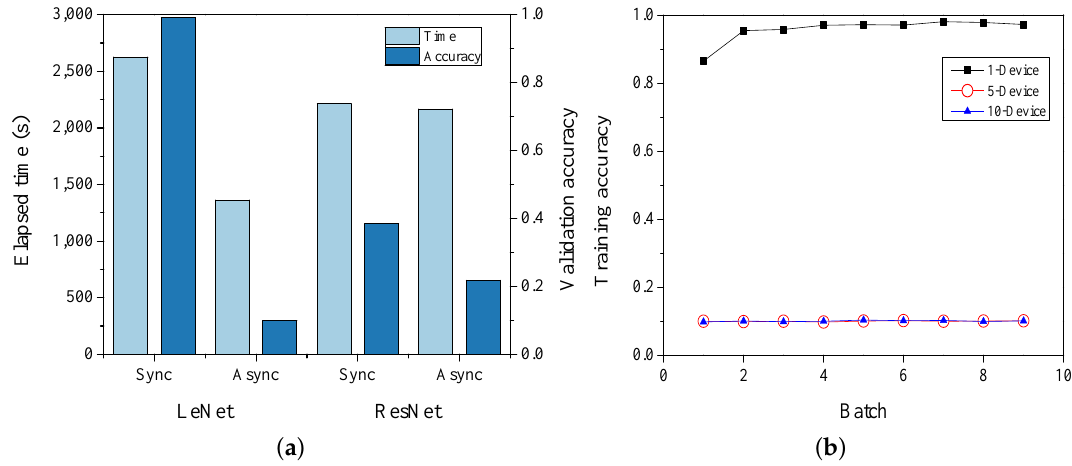
Figure 3. Training results in synchronous and asynchronous method. ( a ) Comparison of time and accuracy according to synchronization method. ( b ) Accuracy in asynchronous distributed training of